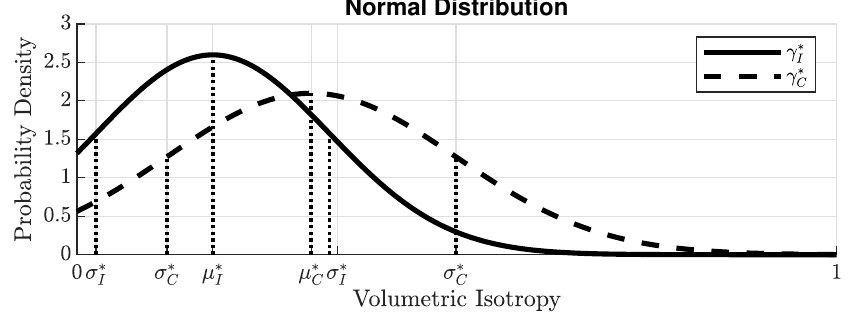
Figure 4. Normal distribution of γ I and γ C